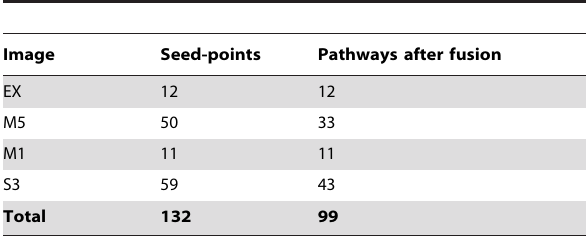
Table 2. Number of seed-points and extracted pathways per